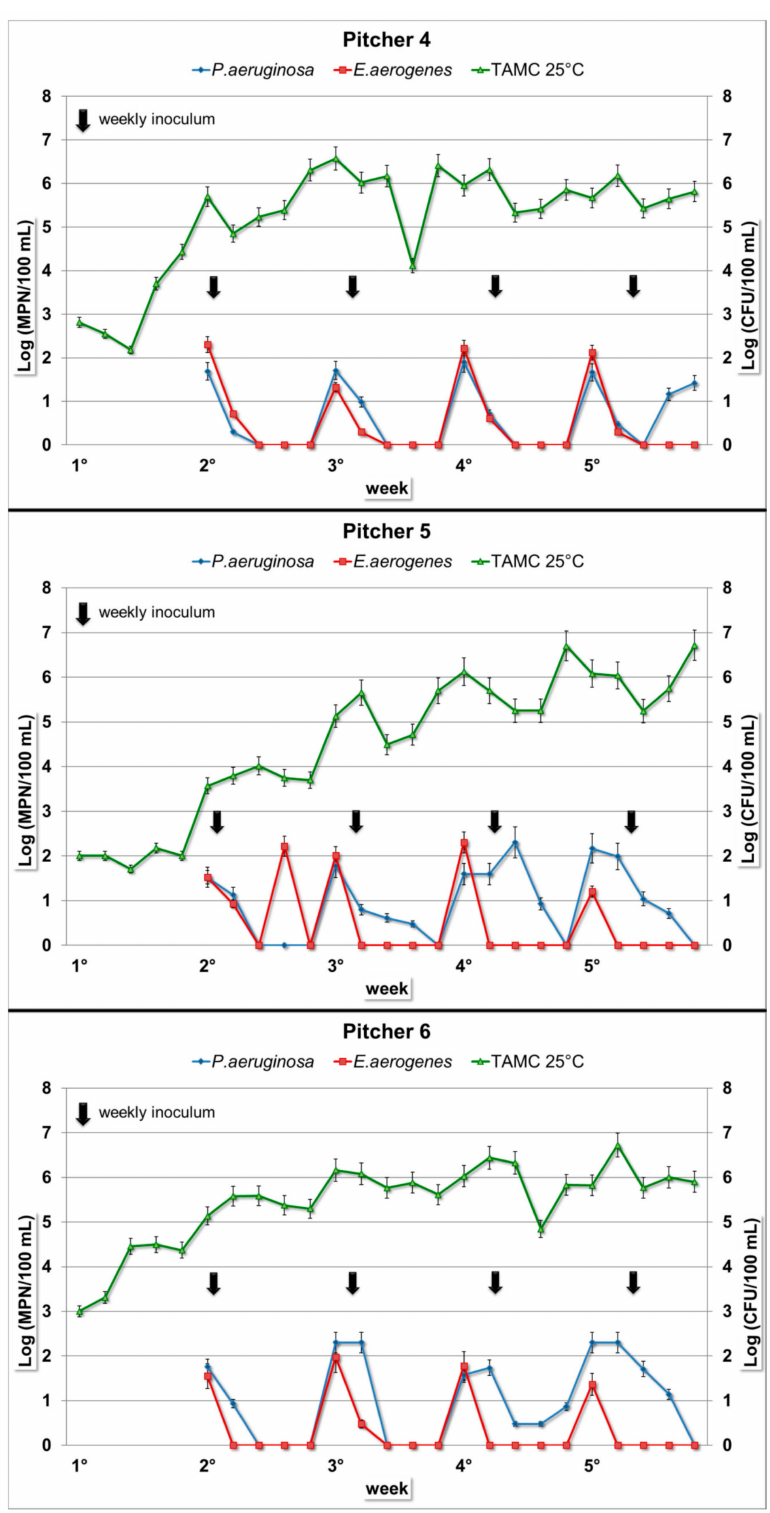
Figure 2. Bacterial concentration trends in daily composite samples in Filter Jugs 4–6. Arrows represent weekly inoculum for both bacteria ( E. aerogenes and P. aeruginosa ). The y -axes show: E. aerogenes and P. aeruginosa concentrations expressed in MPN / 100 mL (left); TAMC at 25 ◦ C expressed in CFU / 100 mL